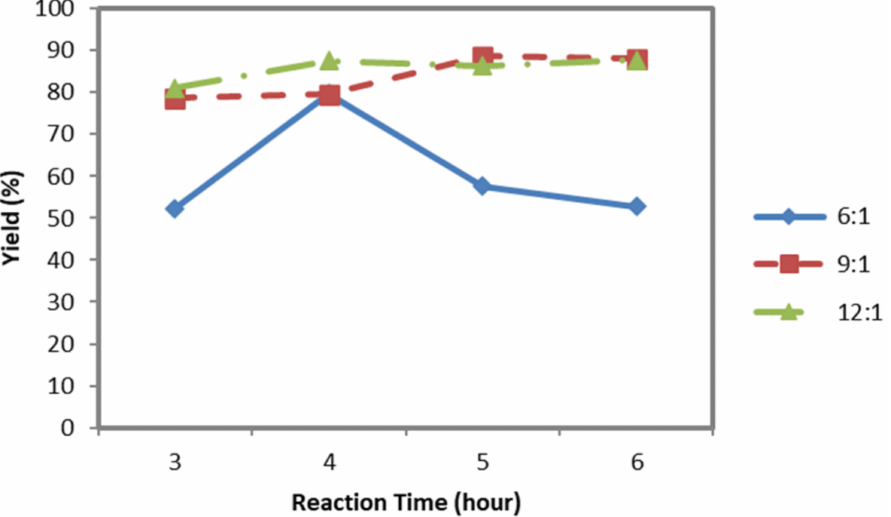
Figure 4. Influence of methanol to oil molar ratio on the yield (catalyst loading 4 wt.%, temperature 55 ◦ C, stirring rate 700 rpm, reaction time 3–6